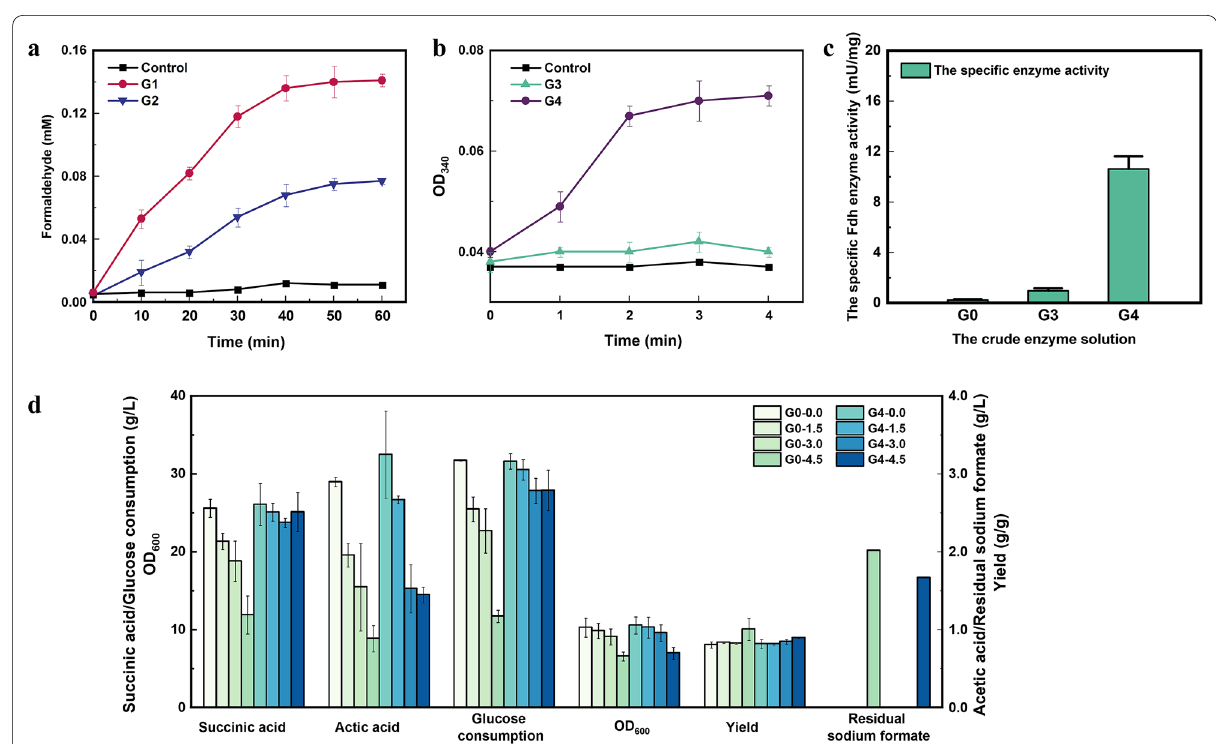
Fig. 2 a Assessment of the two Mdhs by analyzing formaldehyde accumulation. b Assessment of the two Fdhs by analyzing NADH formation and c the calculated enzyme activities. d Optimization of sodium formate concentration gradient